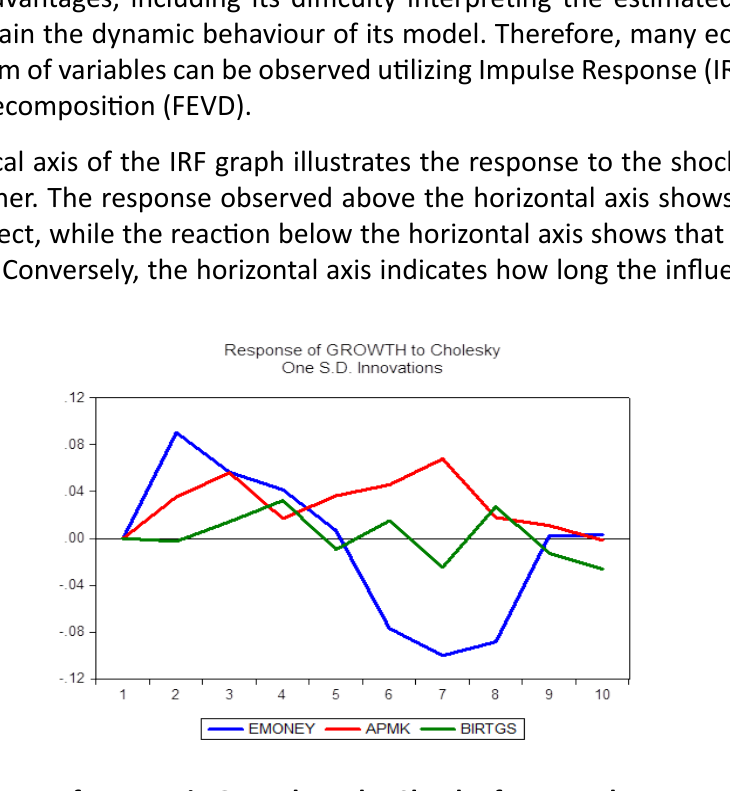
Figure 3: Response of Economic Growth to the Shock of Non-cash Transaction